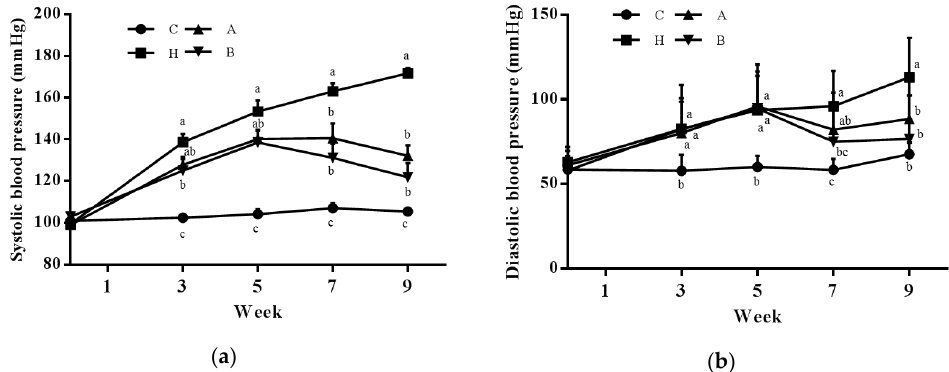
Figure 1. Changes in ( a ) systolic blood pressure (SBP) and ( b ) diastolic blood pressure (DBP) in rats during the experimental period. Values are presented as the mean ± standard error of the mean (SEM) ( n = 10). a b c Values with different superscript letters at the same time point significantly differ ( p < 0.05). C, control group (filled circles); H, hypertensive group (filled squares); A, 20 mg/kg/day antroquinonol group (filled triangles); and B, 40 mg/kg/day antroquinonol group (filled inverted triangles).